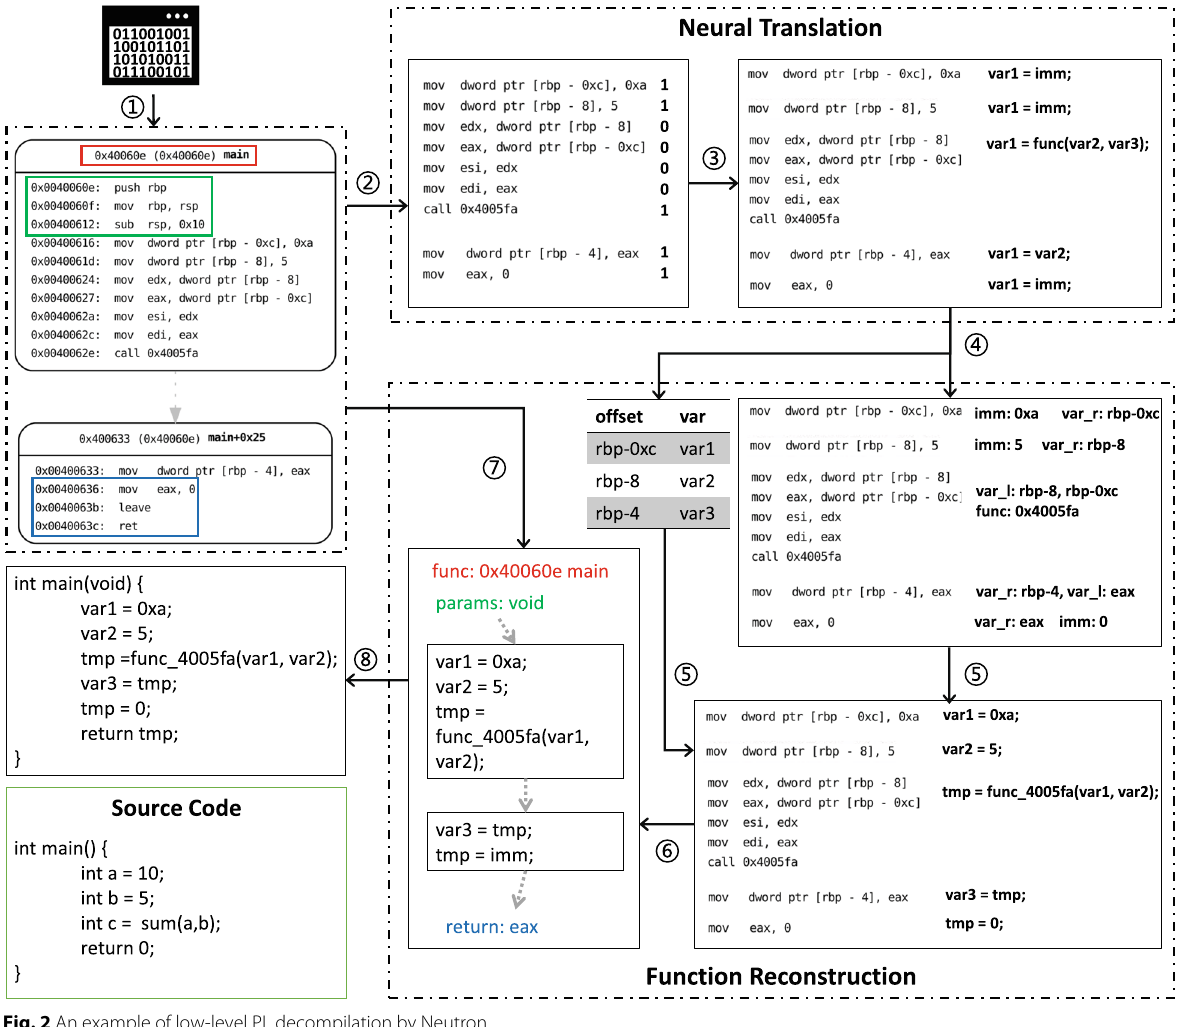
Fig. 2 An example of low-level PL decompilation by